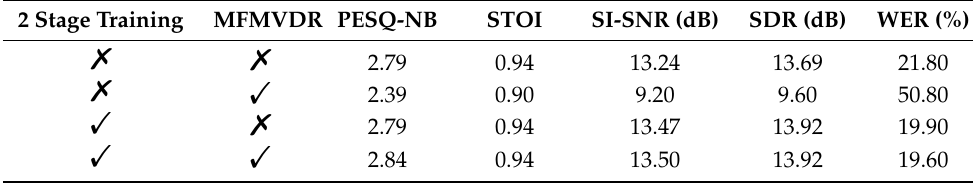
Table 6. Ablation study of two-stage training strategy and MFMVDR.